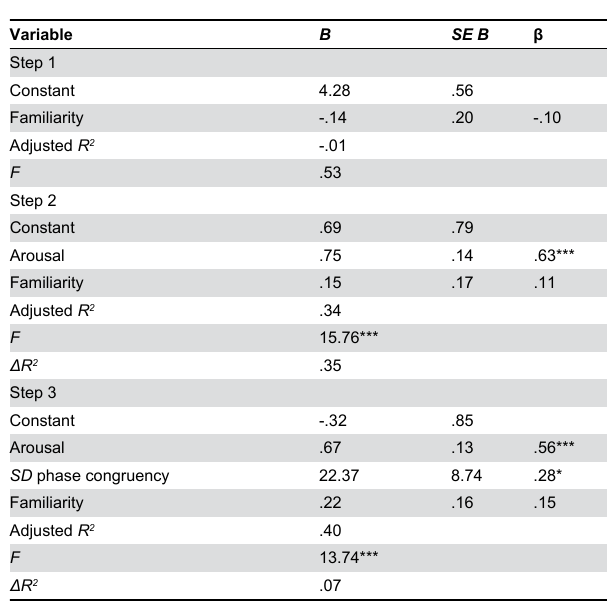
Table 8. Summary of linear stepwise regression analysis for ten variables predicting subjective complexity ratings of